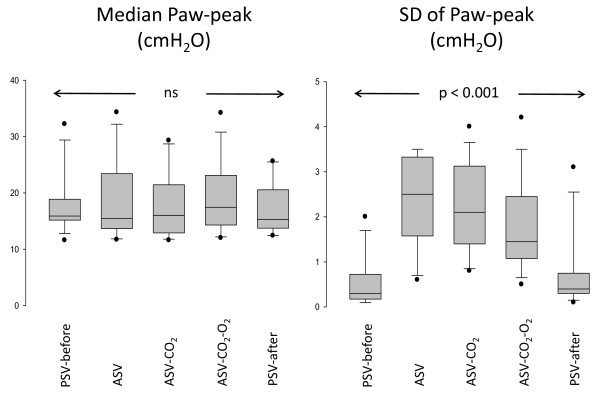
Peak airway pressure of children during the 1-hour periods of mechanical ventilation. Peak inspiratory airway pressure (Paw-peak; median and standard deviation (SD)) of the 14 children included during the five 1-hour periods of mechanical ventilation. The median values were not statistically different, but the SDs of individual breath-by-breath values (right panel) were significantly higher, suggesting more variability in adaptive support ventilation (ASV), ASV and CO2 controller (ASV-CO2) and ASV-CO2 and oxygen controller (ASV-CO2-O2) as compared with pressure support ventilation (PSV).